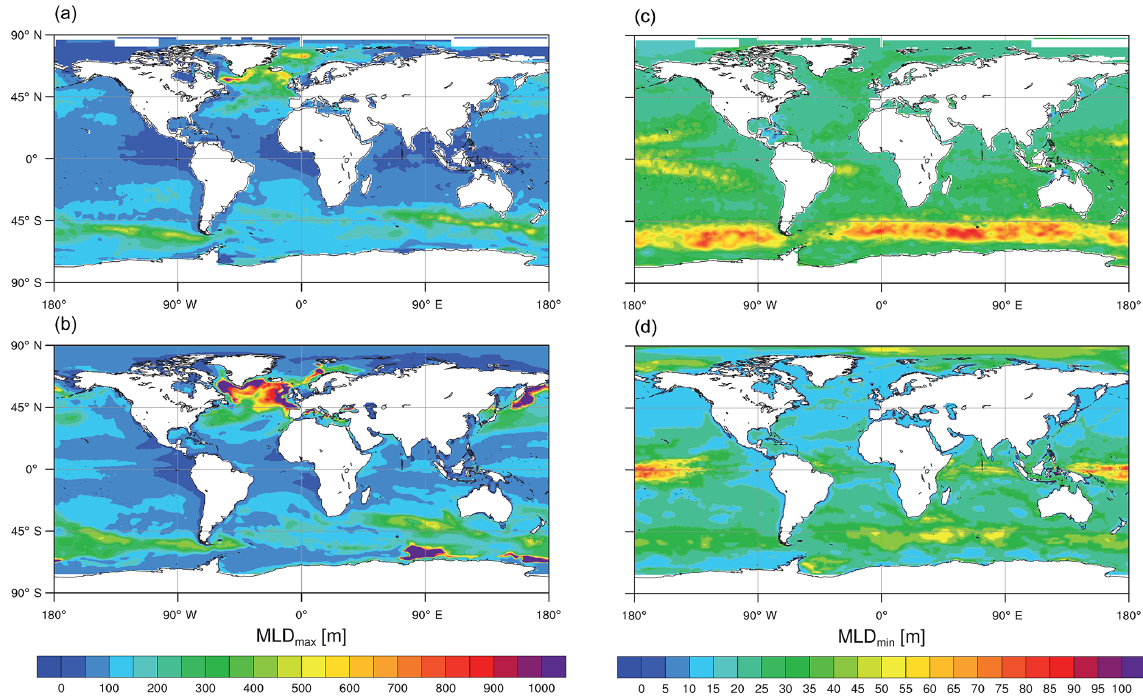
Figure 7. Composite of yearly extremum of mixed-layer depth over 1986–2005. Left panels represent the maximum mixed-layer depth (MLD max ) for (a) observations (Sallée et al., 2010) and (b) CNRM-ESM1. Right panels represent the minimum mixed-layer depth (MLD min ) for observations (c) and CNRM-ESM1 (d)